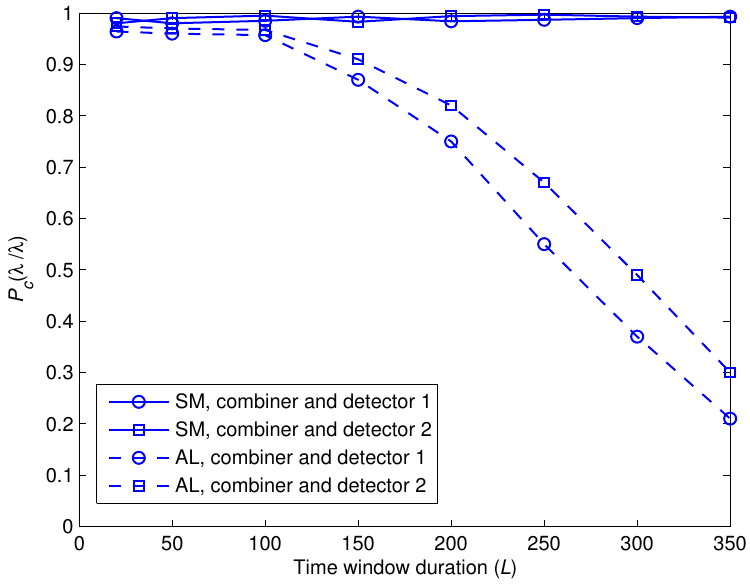
Figure 7. Effect of L on the classification performance of the two combiners and